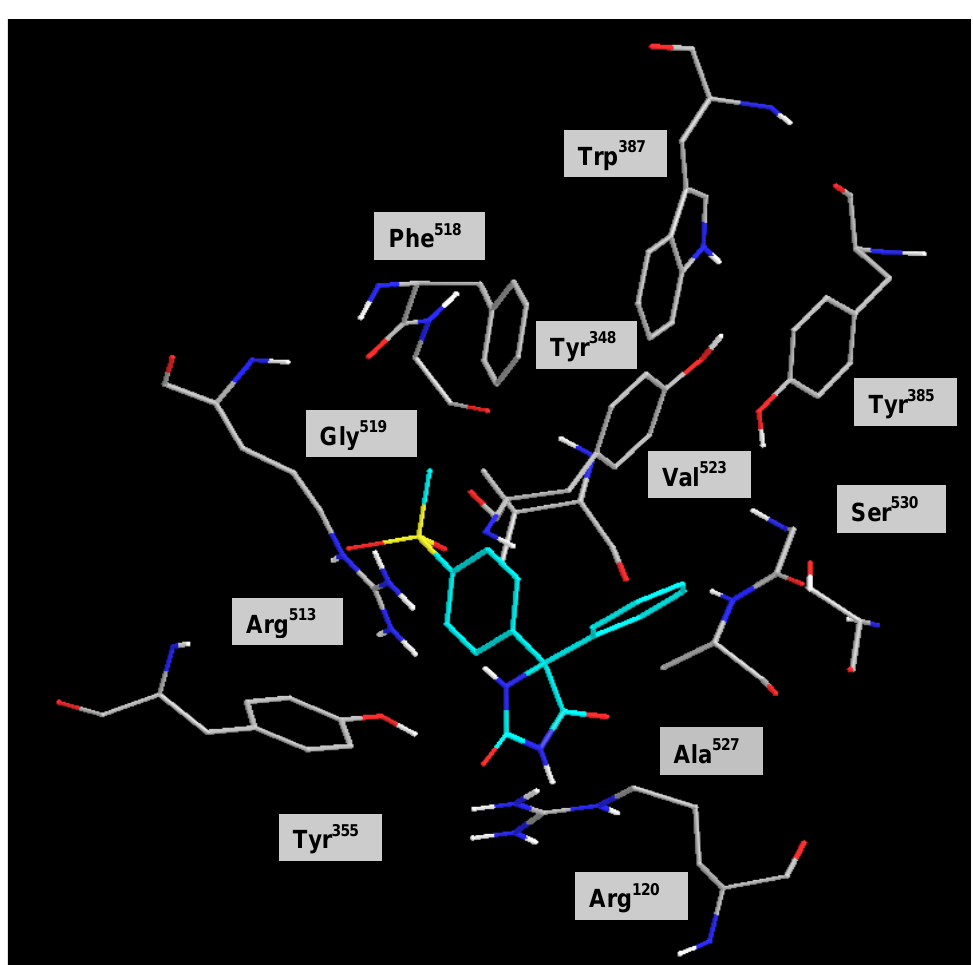
Fig. 2. Docking of 4 in the active site of murine